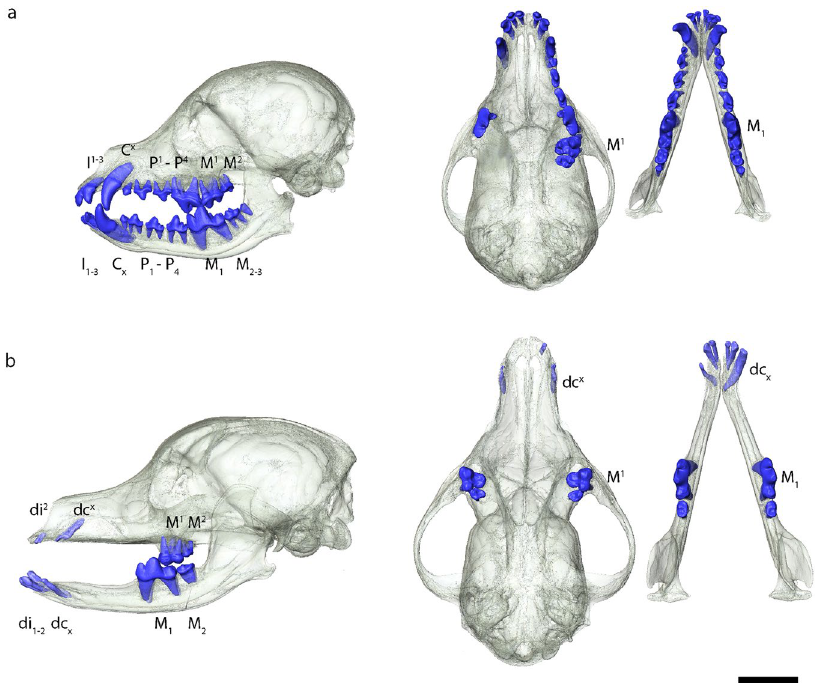
Figure 1. Dental phenotype in ( a ) normally coated dog (MAM1491) and ( b ) hairless dog (MAM1494). 3D renderings of skulls (transparent) and teeth in lateral (left) and superior view (right). Note missing premolars and canines in hairless type; only the molars and the deciduous incisors and canines are present. In the coated dog there are some maxillary postcanine teeth on the right side missing due to post mortem tooth loss. The black scale bar equals 5